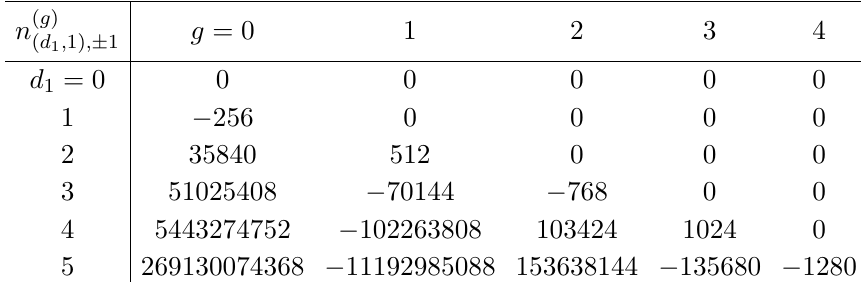
Table 26 . Base degree 1 Gopakumar-Vafa invariants for X (4)